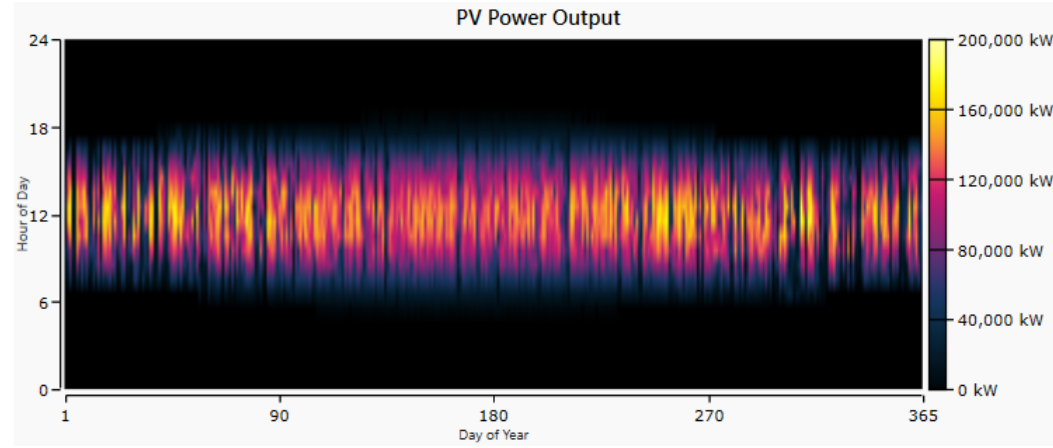
Figure 10. PV power output, Zagazig.